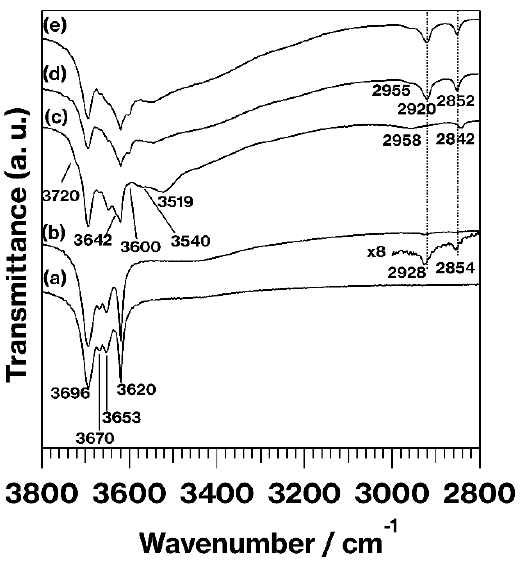
Figure 2. IR spectra in the range of 3800-2800 cm − 1 obtained from (a) kaolinite, (b) C18TAC/kaolinite_Wash, (c) MeO-Kaol, (d) C18TAC/MeO-Kaol_Wash, and (e) C18TAB/MeO-Kaol_Wash.